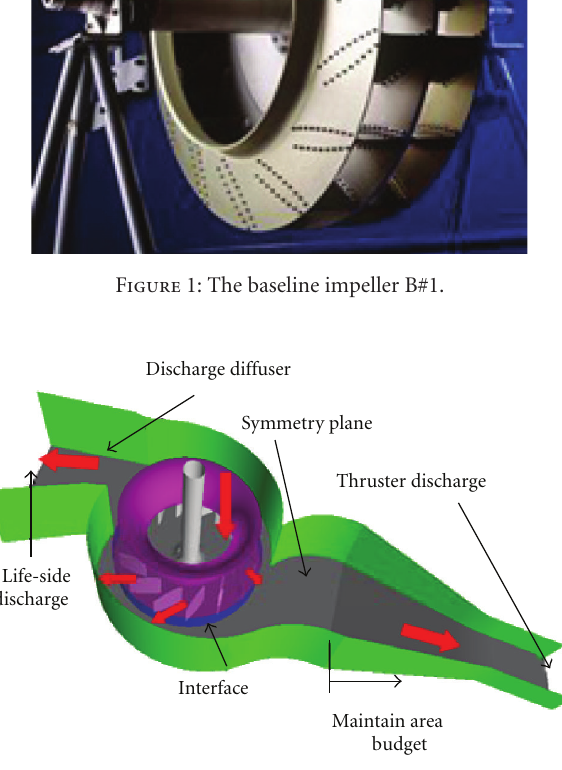
Figure 2: Component representation for a half of the centrifugal